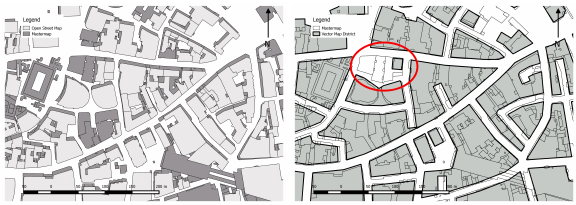
Figure 4: OSMM/OSM (left) and OSMM/VMD overlay (right) showing missing buildings - OSMM buildings are shown with a thin black outline and no fill, VMD with a thick black outline